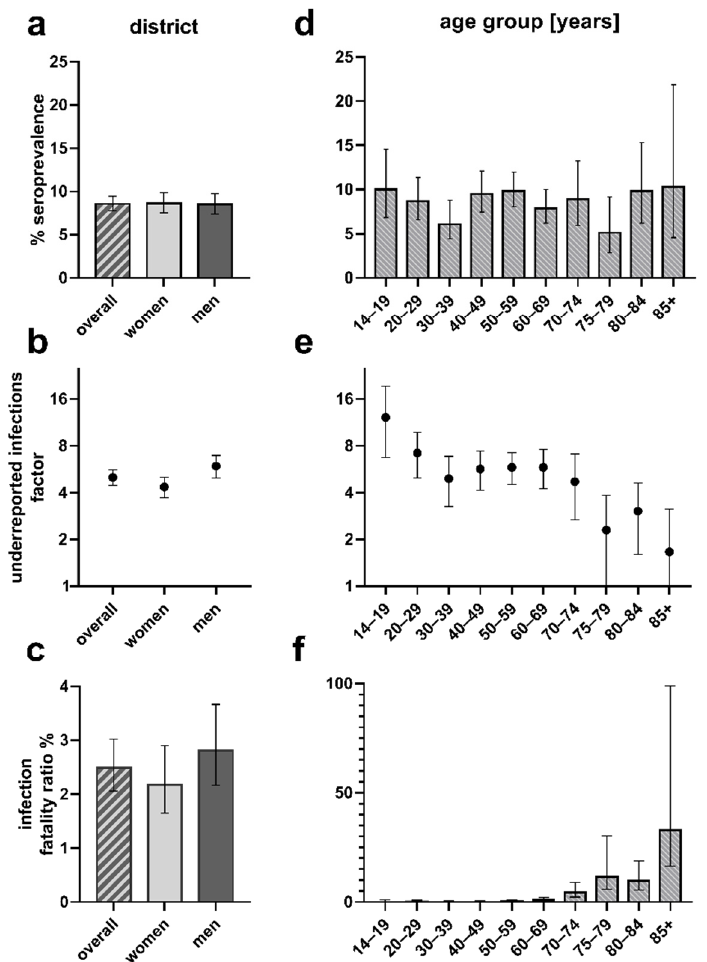
Figure 2. Seroprevalence, factor of underreported infections, and infection fatality ratios overall and by age groups. Standardized seroprevalence (%), dark figure factor and infection fatality ratio (%) in the overall county population ( a – c ) and the indicated age groups ( d – f ). Error bars represent 95% confidence intervals (95%-CI), respectively. Figure was designed using GraphPad Prism version 8.4.3 for Windows, GraphPad Software, La Jolla, CA, USA, www.graphpad.com.